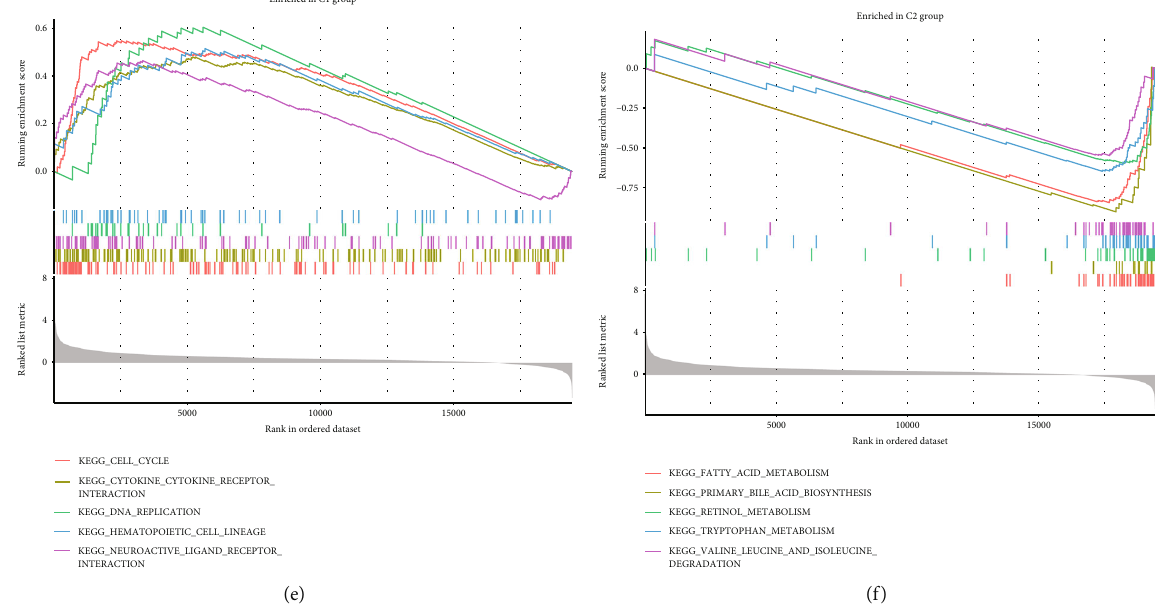
Figure 3: Results of functional enrichment analysis. (a) A list of the top 10 enriched GO terms. Topics contained biological processes (BP), cellular components (CC), and molecular functions (MF). (b) The top 30 most signi fi cant enriched KEGG pathways. (c) The top 5 GSEA- GO enrichment in cluster 1. (d) The top 5 GSEA-GO enrichment in cluster 2. (e) The top 5 GSEA-KEGG enrichment in cluster 1. (f) The top 5 GSEA-KEGG enrichment in cluster 2.